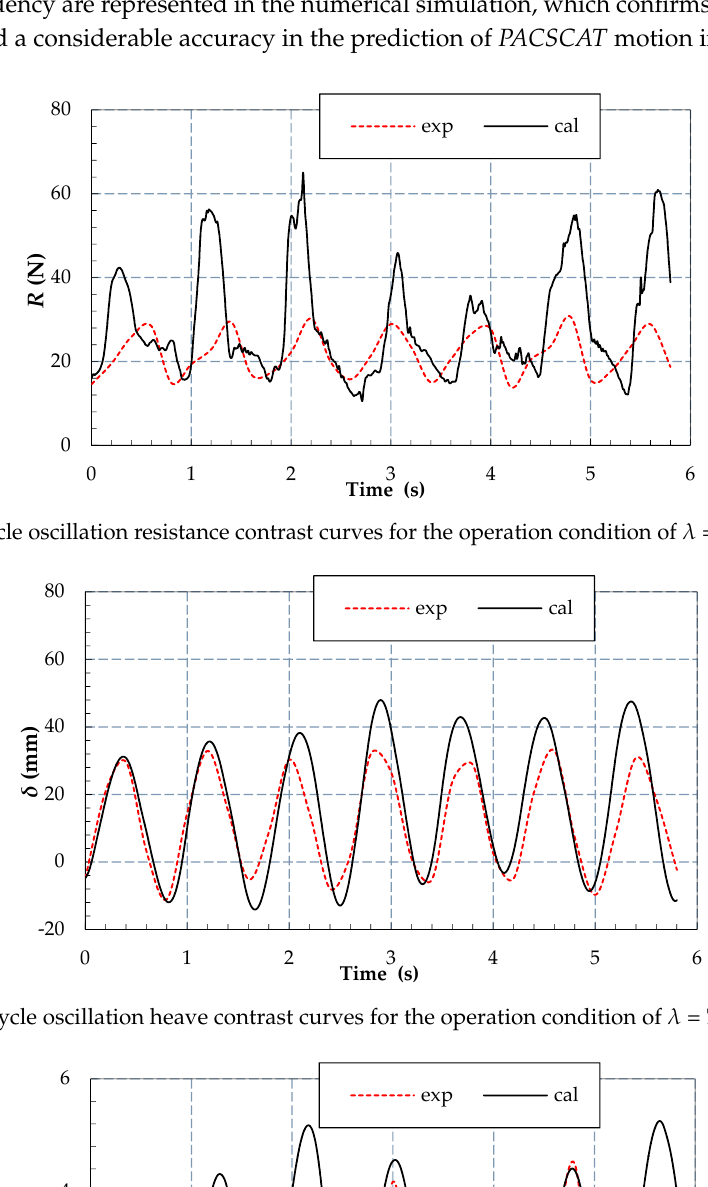
Figure 24. Cycle oscillation acceleration contrast curves for the operation condition of λ = 7 m, F n = 0.99. In Figures 25–27, the calculated and experimental motion amplitudes of heave, pitch, and midship acceleration, respectively, are plotted as functions of encountered frequency ω e . It can be seen from the heave curves that the curve hump, which located at the nature frequency, moves to the high-frequency region as the speed is increased. The difference between the calculation and experiment is not obvious at the high-frequency region ( ω e > 8), but the predicted natural frequency of heave is a little higher than the experimental value. Compared with the response curves of pitch, the calculated results show good agreement at the Froude number of 0.71, but departure severely at higher speeds, while they fail to capture the natural frequency as well. For the acceleration, the divergence becomes evident in the hump region for the calculated speeds. ( a )